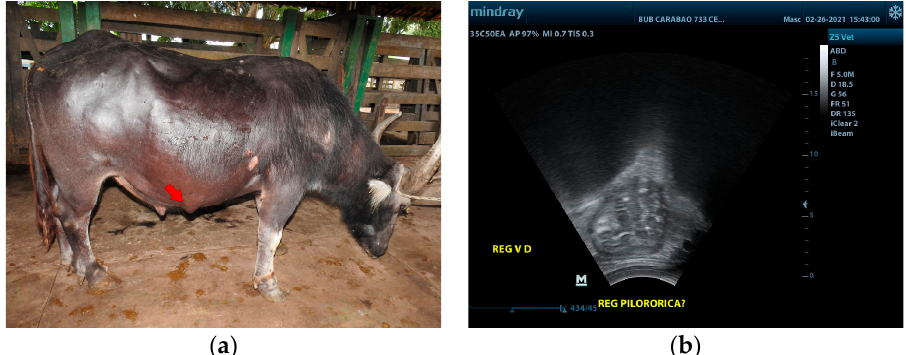
Figure 2. Distal vagal indigestion in Buffalo 2: ( a ) abdominal distention with eventration (arrow); ( b ) segment of the pylorus adhered to the eventration on the ultrasonograph.